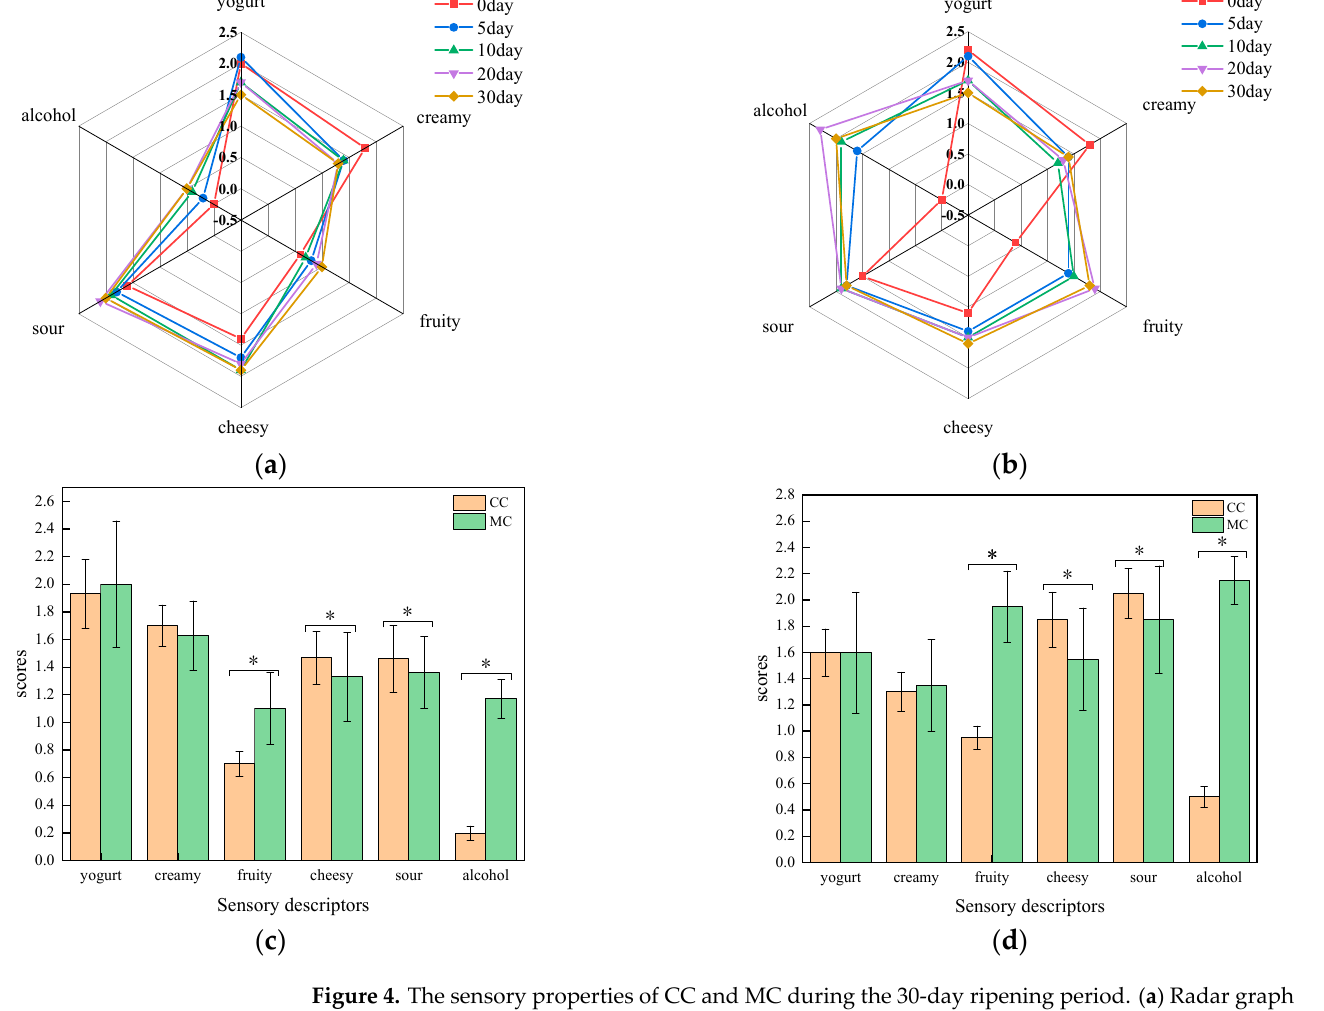
Figure 4. The sensory properties of CC and MC during the 30-day ripening period. ( a ) Radar graph displaying sensory evaluation results of CC; ( b ) radar graph displaying sensory evaluation results of MC; ( c ) the average scores of sensory descriptors of CC and MC during the 0–10-day period; ( d ) the average scores of sensory descriptors of CC and MC during the 10–30-day period. CC and MC represent cheese samples collected from control cheeses and Monascus -fermented cheeses, respectively (* corresponds to statistically significant differences ( p < 0.05)).